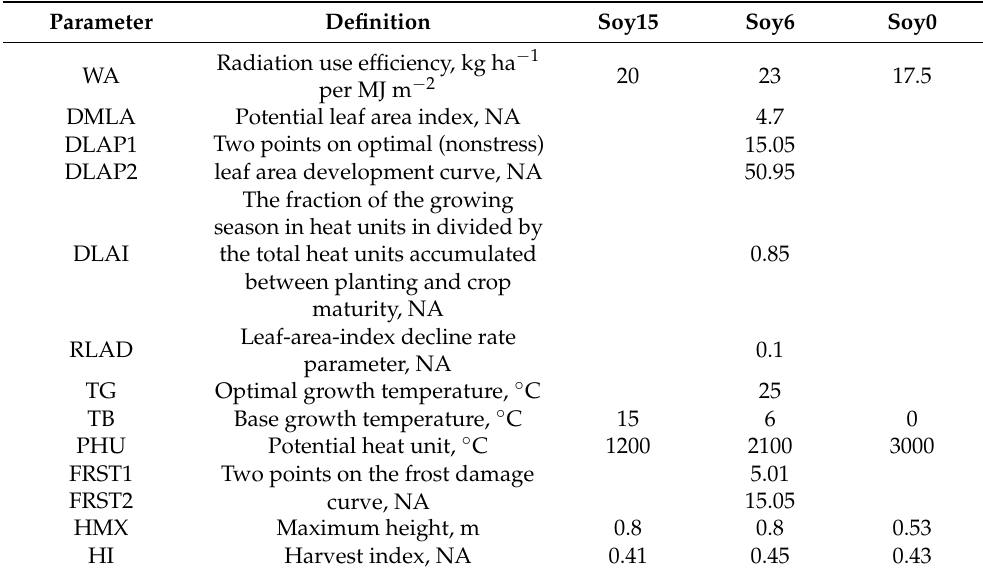
Table 3. Key plant parameters of Soy15, Soy6, and Soy0 used in ALMANAC model calibration. NA represents ‘no